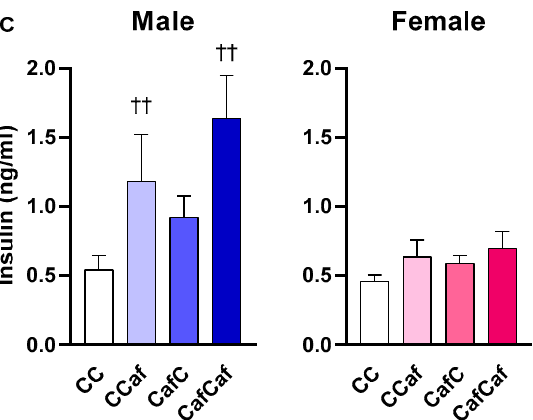
Figure 10. Plasma leptin ( A ), triglyceride ( B ), and insulin ( C ) levels in male and female offspring at 14 weeks. ChowChow (11 male, 11 female), ChowCaf (11 male, 11 female), CafChow (13 male, 11 female), and CafCaf (13 male, 13 female); C depicts chow. Data are expressed as mean ± SEM and were analysed by two-way ANOVA. ** p < 0.01 main effect of maternal Caf diet, †† p < 0.01 main effect of offspring postweaning diet.